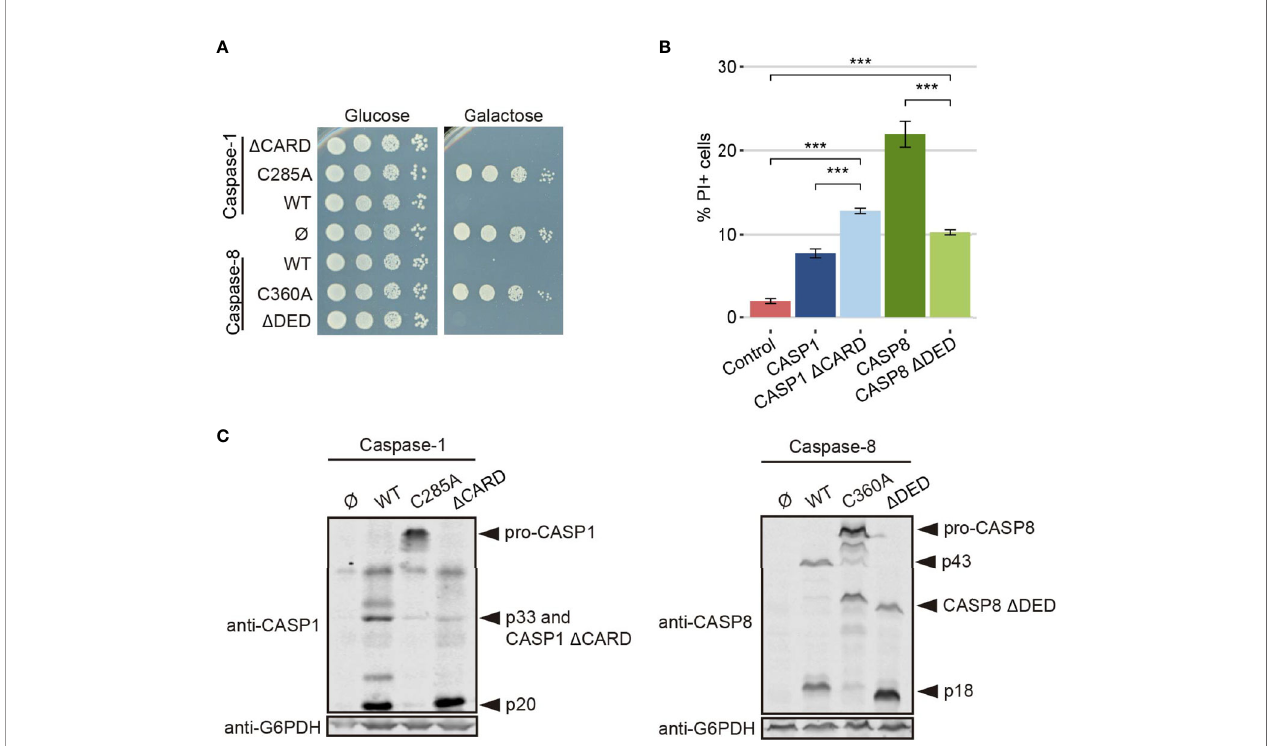
FIGURE 7 | CARD and DED domains have opposite effects on the respective caspase activity. (A) Spot growth assay of BY4741 strain bearing pAG413-caspase-1 and pAG413-caspase-8, the plasmids with their respective catalytically inactive mutants pAG413-caspase-1 C285A and pAG413-caspase-8 C360A, and the plasmids with their respective mutant lacking of DD pAG413-caspase-1 D CARD and pAG413-caspase-8 D DED. pAG413 empty vector was used as a negative control. Cells were cultured on SD (glucose) or SG (galactose) agar media for induction of caspase-1 and caspase-8 expression. A representative assay from three different experiments with different transformants is shown. (B) Graph showing the percentage of positive PI stained cells of each population of BY4741 strain bearing the same plasmids as in panel (A) after 5 h of induction in SG medium. Results correspond to the mean of three biological replicates performed on different transformants. Error bars represent SD. Asterisks (***) indicate a p-value < 0.001 by the Tukey ’ s HSD Test. Only signi fi cance levels between mutant caspases (CASP1 D CARD and CASP8 D DED, their wild type counterpart, and control cells are represented. (C) Immunoblots showing the expression of wild type and the different mutants of caspase-1 (left panel) and caspase-8 (right panel) in yeast lysates of the cells bearing the same plasmids as in (A) after 5 h induction in SG medium. Membranes were hybridized with anti – caspase-1 and anti – caspase-8 antibodies. Anti-G6PDH antibody was used as a loading control. A representative assay from three different experiments with different transformants is